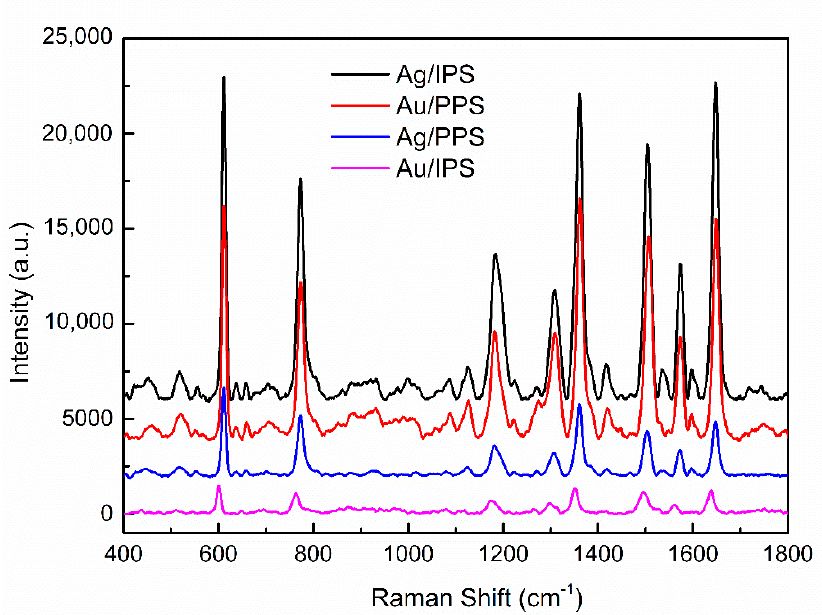
Figure 7. The SERS spectra of R6G (10 − 6 M) gathered on four pyramidal SERS substrates.